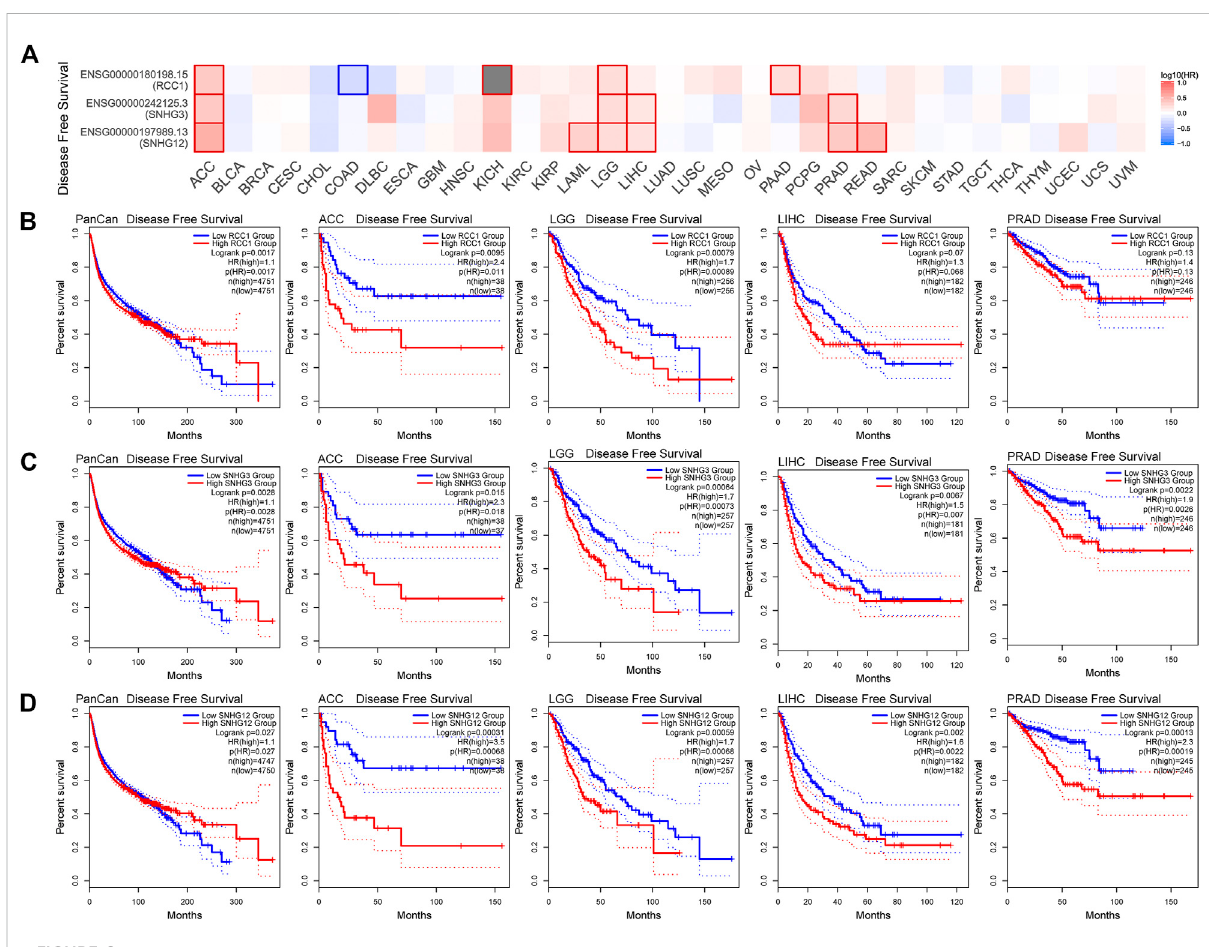
Correlation between RCC1/SNHG3/SNHG12 expression and disease-free survival of tumors. (A) Survival map of the correlation between the expression of RCC1/SNHG3/SNHG12 and the disease-free survival of patients in different tumors. (B – D) K-M plot of disease-free survival of